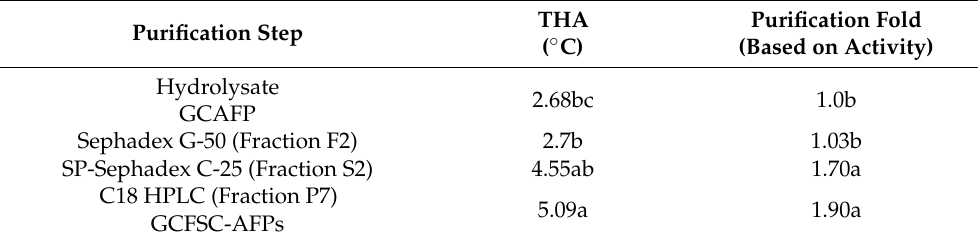
Table 2. The purification folds of GCFSC-AFPs from the Ctenopharyngodon idella scales. Purification Step